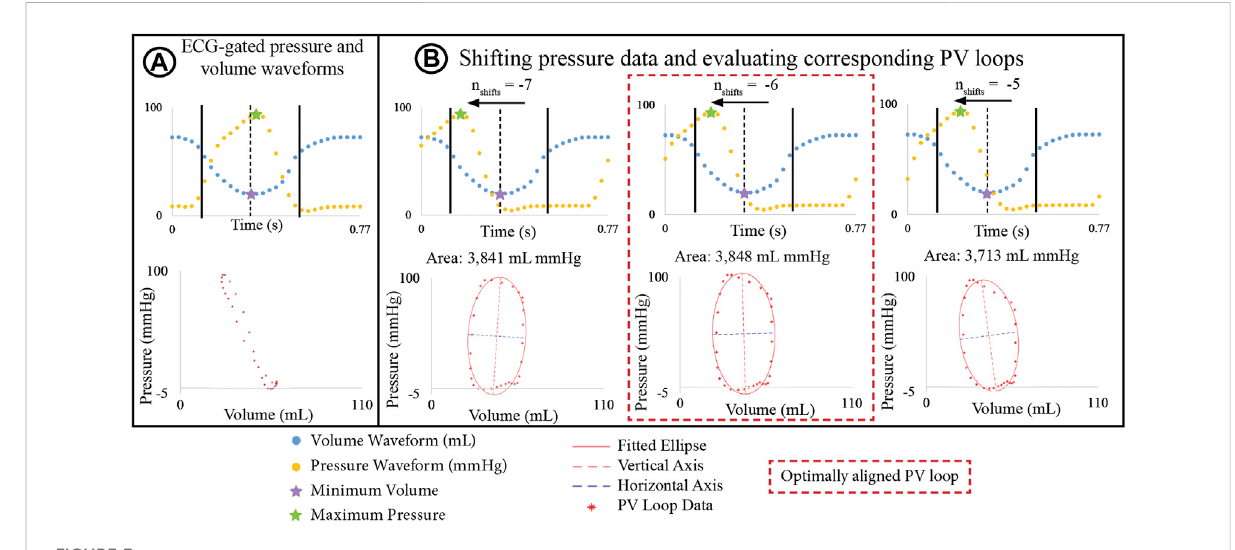
FIGURE 3 (A) PV loop built by ECG-aligning pressure and volume waveforms shows physiologically unrealistic shape. (B) Optimization algorithm incrementally shifts pressure waveforms to de fi ne a new PV loop and an ellipse is fi tted to the PV. The optimally aligned PV loop, showing clearly de fi ned isovolumetric relaxation and contraction phases, is that with the largest